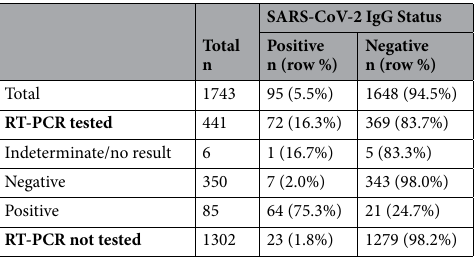
Table 2. SARS-CoV-2 RT-PCR result by SARS-CoV-2 IgG status.